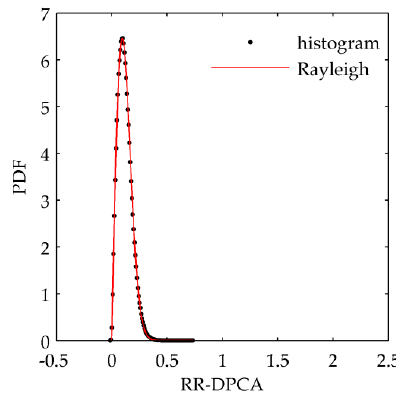
Figure 8. RR-DPCA histogram and estimated Rayleigh PDF of the real data.